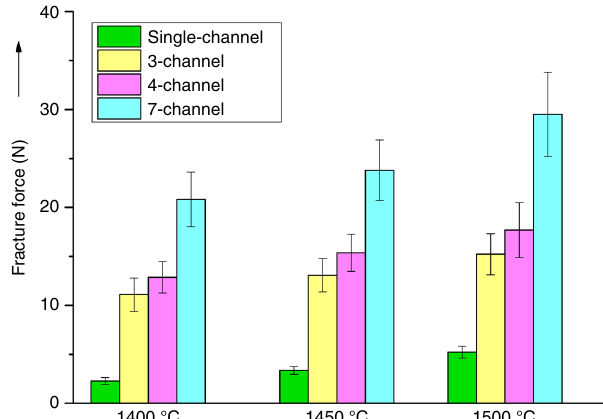
Table 1 Comparison of volumetric power density with reported honeycomb-SOFCs